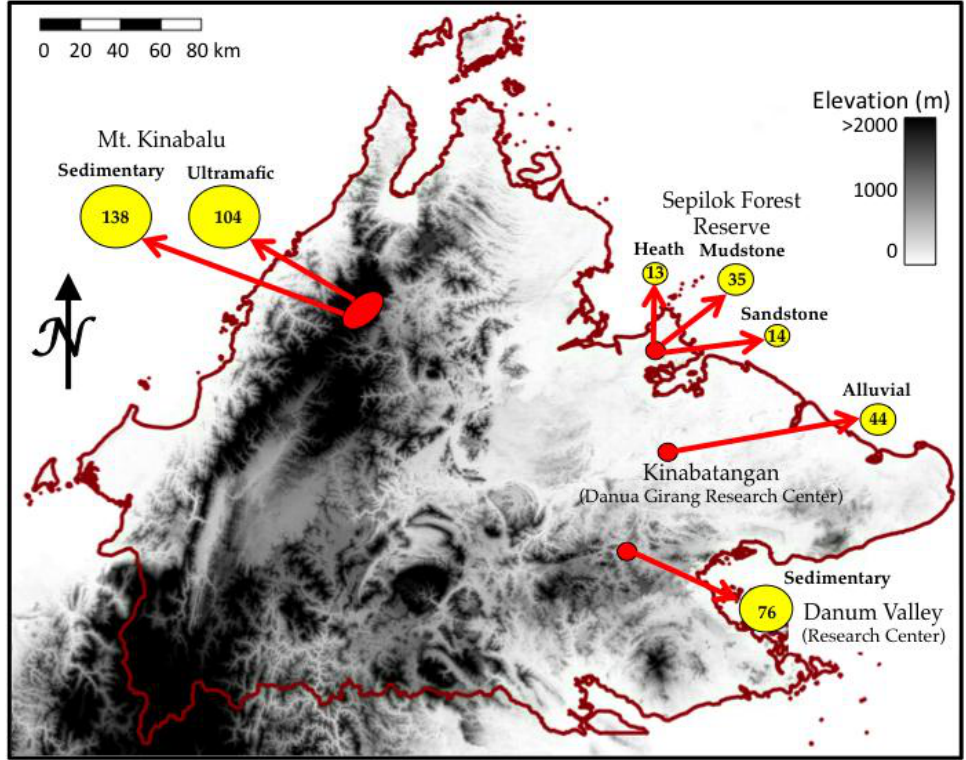
Figure 1. Map of elevation across Sabah, Malaysia showing four locations (red circles) where canopy foliar traits were collected in the field for development and testing of the retrieval of foliar traits from airborne spectroscopy data. The numbers in the yellow circles indicate the number of canopies sampled on the corresponding soil substrate.